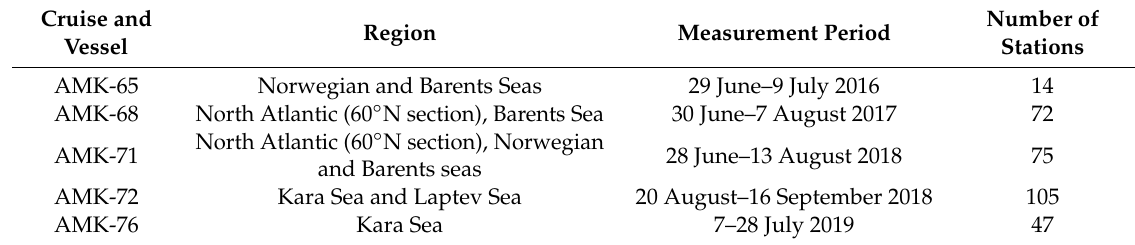
Table 1. The Arctic and Atlantic R / V AMK voyages with measured